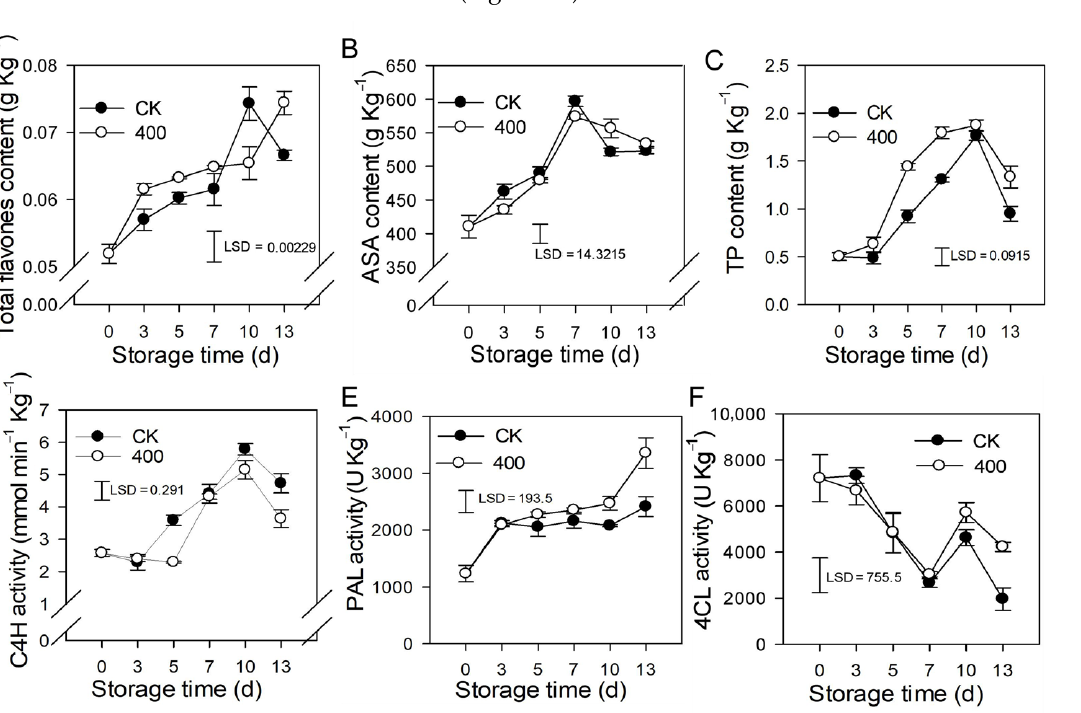
Figure 4. Effects of melatonin application on lignin biosynthesis enzymes activity and other defense- related substances in papaya fruit. ( A ) Effect of melatonin application on total flavones ( B ) ASA ( C ) TP ( D ), C4H ( E ) PAL ( F ) 4CL activity. The experiments were carried out in triplicate and each data point shows the mean ± SE ( n = 3). To compare significant effects at the 5% level, least significant differences (LSDs) were determined. CK: control group, “400” indicated the “400 μmolL − 1 ” melato- nin treatments.